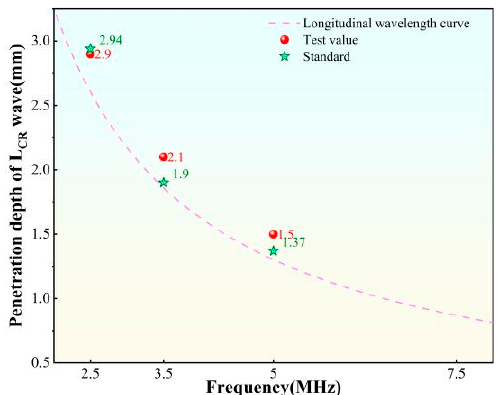
Figure 12. Comparison of test result, standard and wavelength curve.